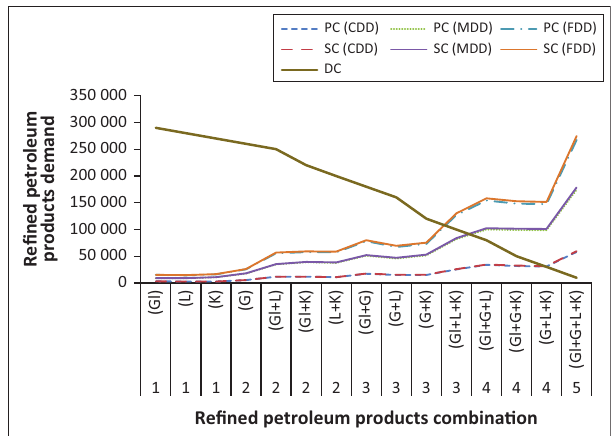
FIGURE 3: Private and social cost graph.